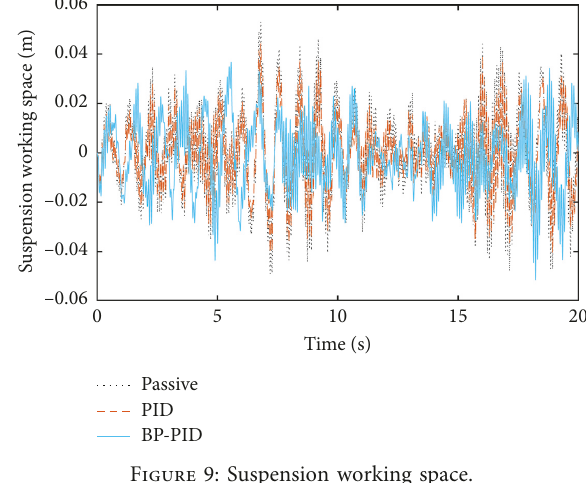
Figure 9: Suspension working space.